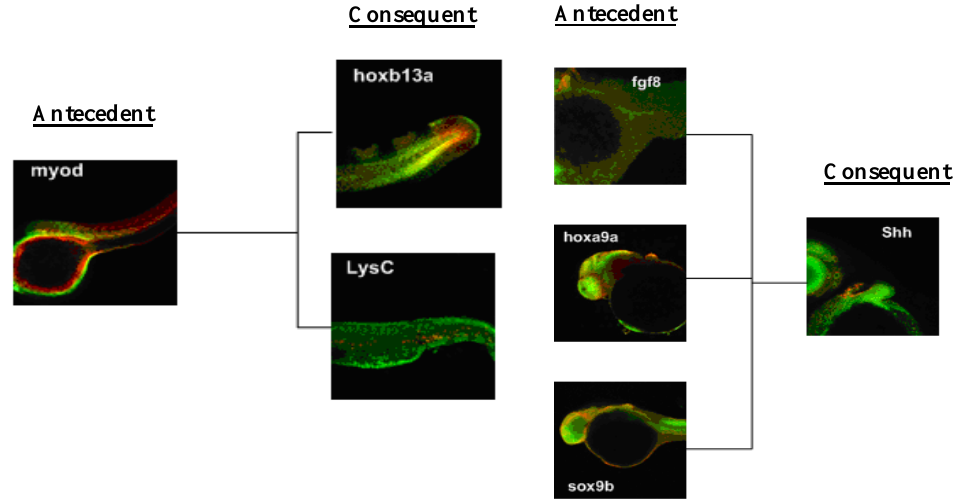
Figure 2: An example extracted from the result set of the PPM algorithm (support >=30% and confidence >= 75%) on the GEMS dataset. The first tree genes have a common expression in tail while the second tree contains rules with genes having a common expression in fin (in the body region). The depicted (thumbnail-) images of patterns of gene expression are realized from 2D projections of the dual-channels image stack that was obtained with